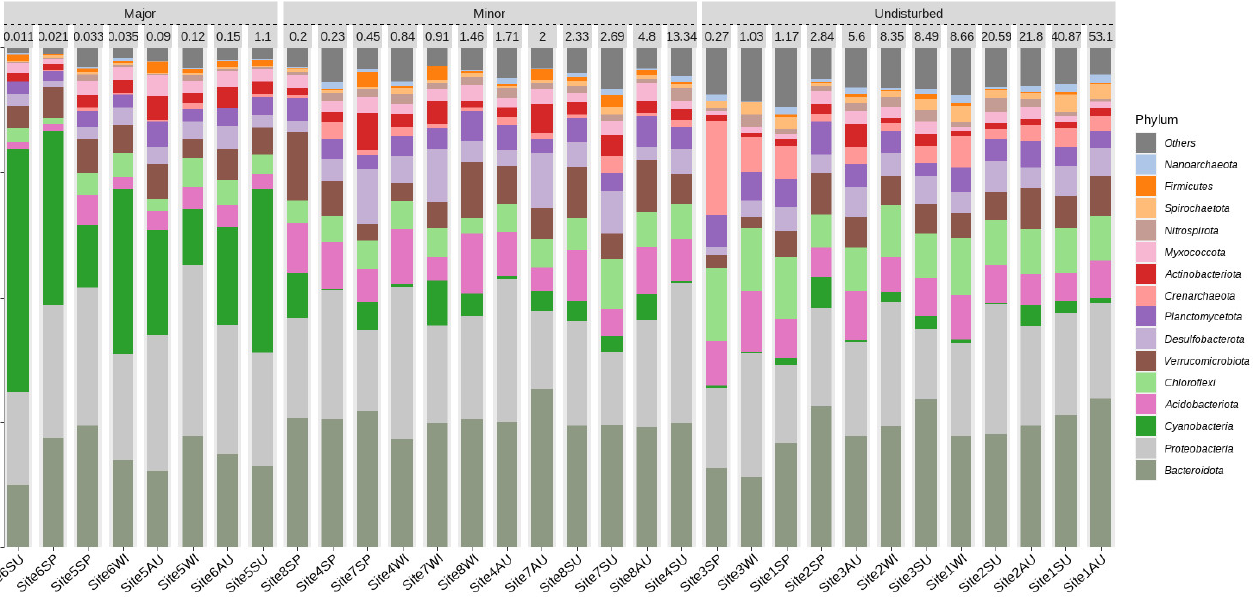
Figure 4. A bar plot describing the relative abundance of various phyla as a function of the level of disturbance. Samples with 15 the most abundant phyla among all the samples are grouped by the level of disturbance and are sorted from lowest to highest concentration ( µ g kg − 1 ) of MeHg within each level.